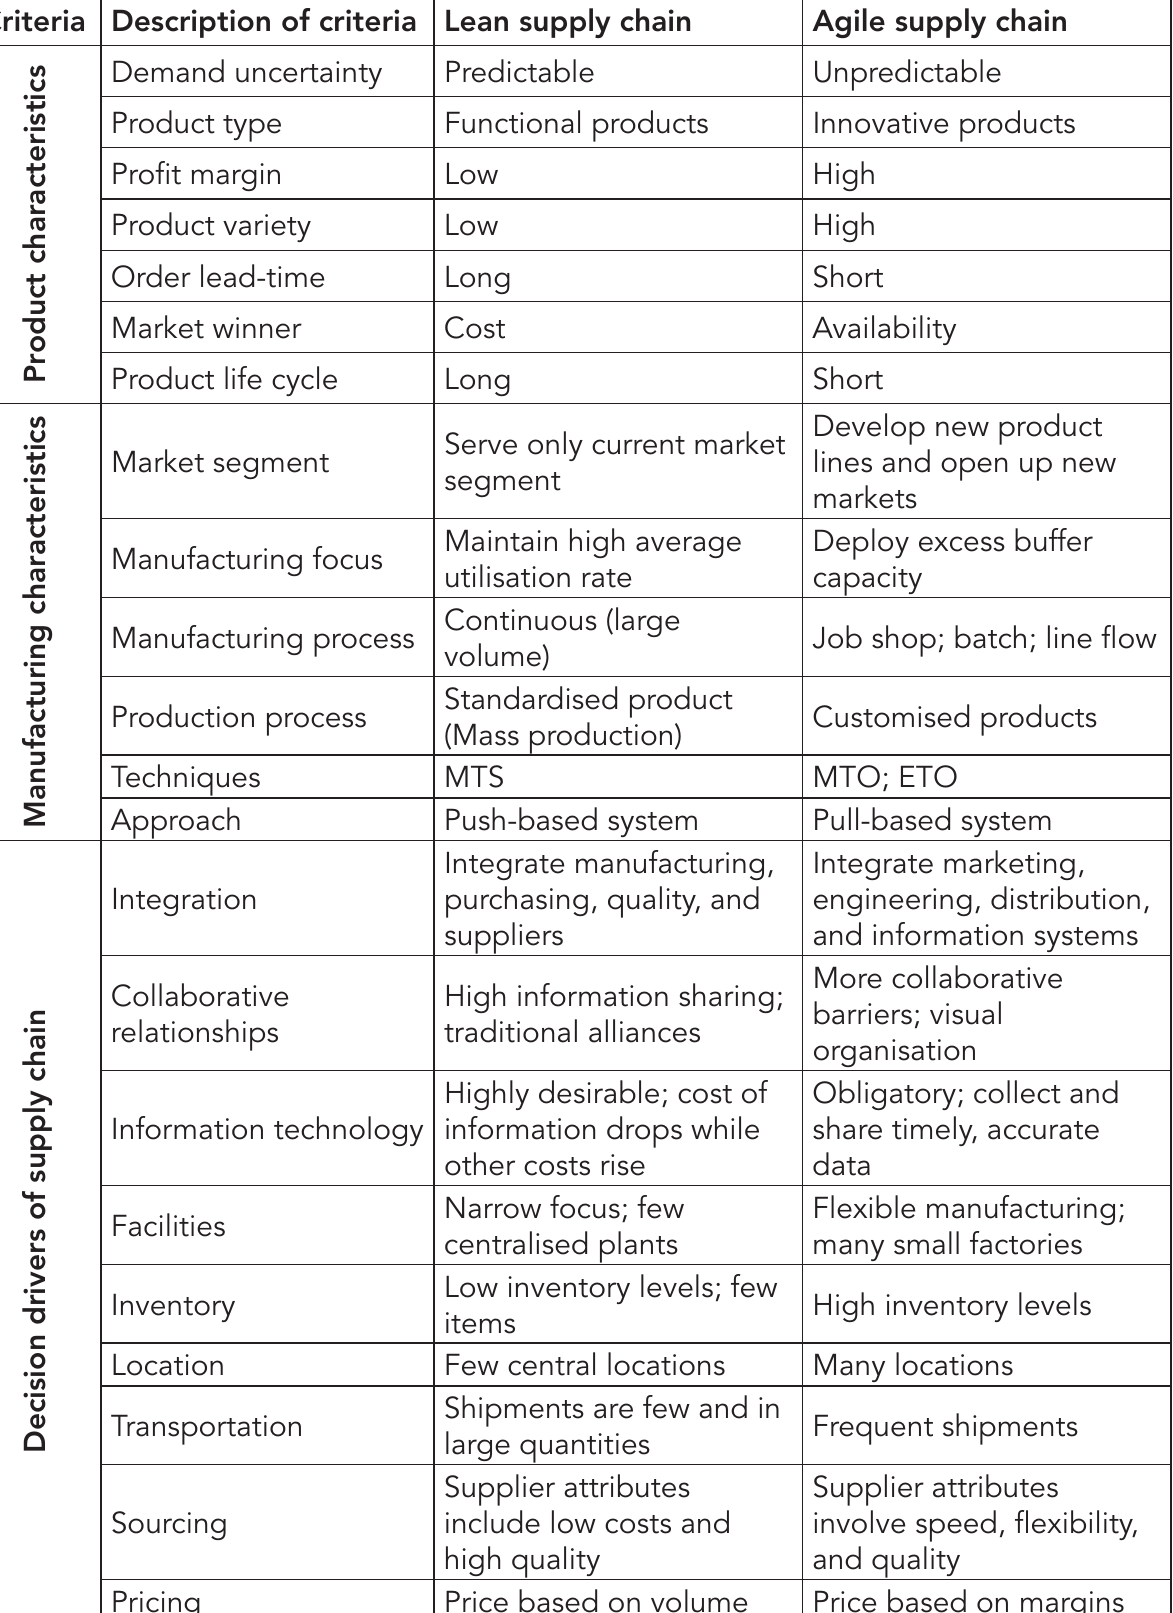
Table 4: Comprehensive framework for determining supply chain strategies and practices